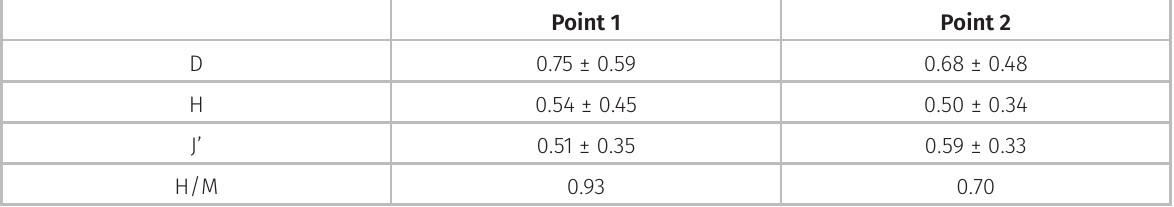
Table VII. Diversity indexes of the metazoan parasite communities in Hoplias malabaricus (Bloch, 1794) specimens collected between February 2014 and June 2016 at two points on the Batalha River in São Paulo State, Brazil (D = species richness according to the Margalef index; H = Brillouin diversity; J’ = Pielou’s evenness index; H/M = ratio between the sum of heteroxenous and of monoxenous parasites). All means followed by ± standard